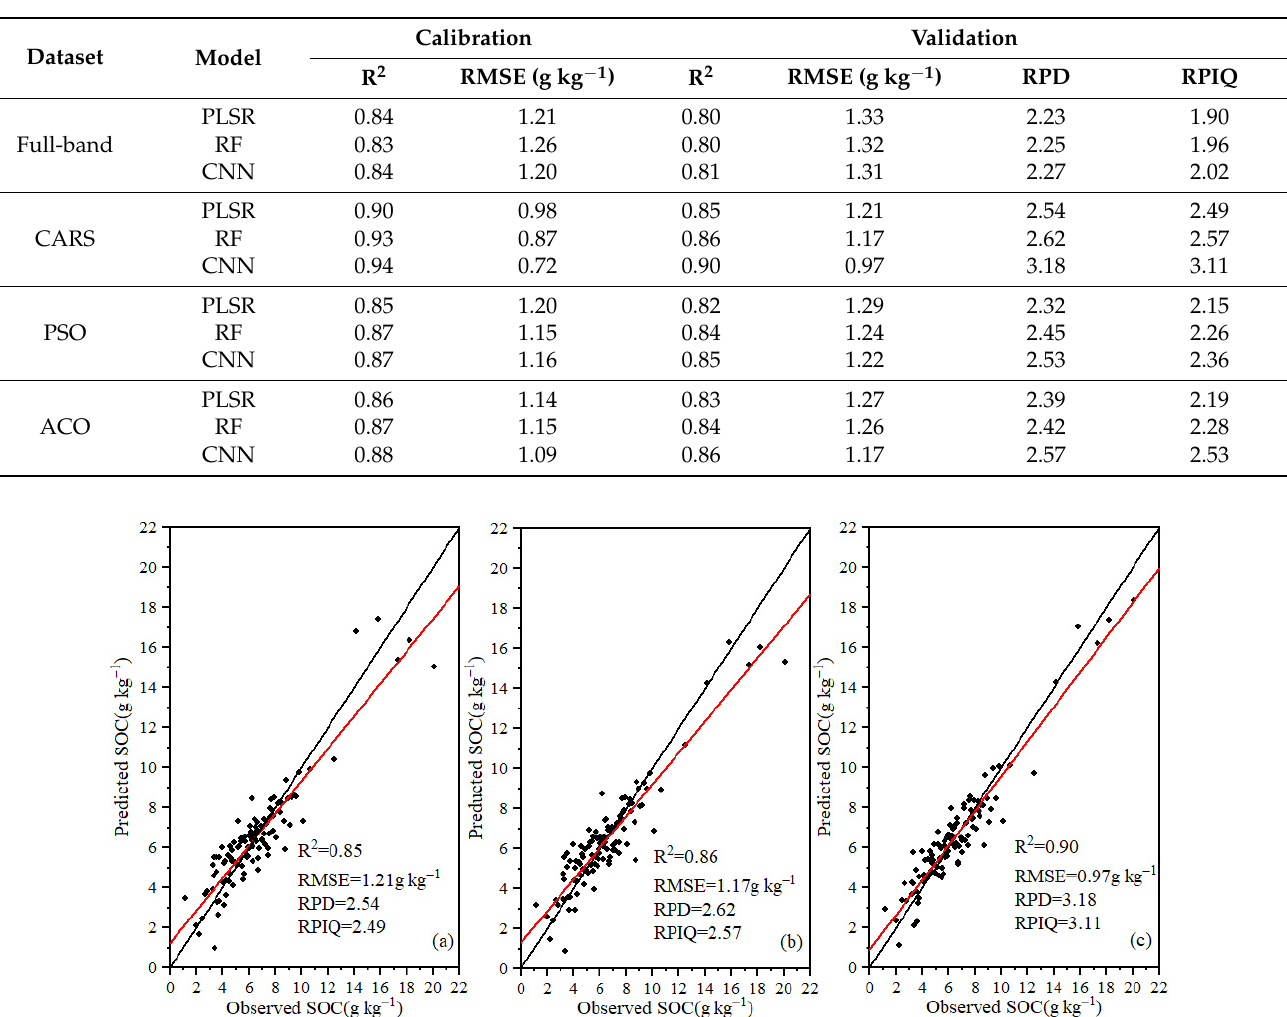
Table 2. Prediction accuracy of different models for SOC.